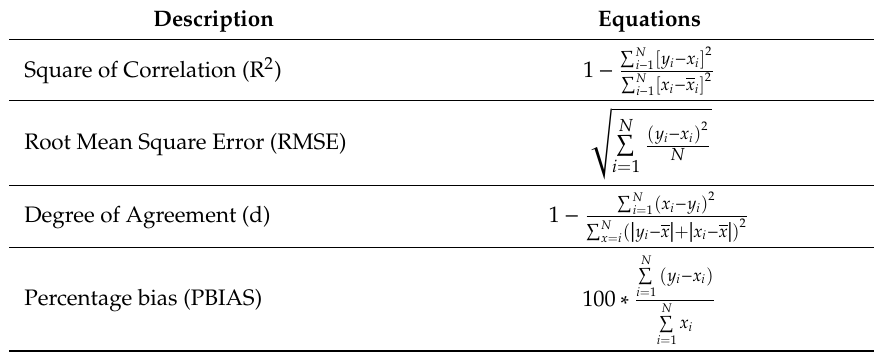
Table 2. Summary of the performance statistics used in this study. In the following equations, x and y represents observed and simulated data sets, respectively. N is the total number of observations. x and y are the mean of x and y ,